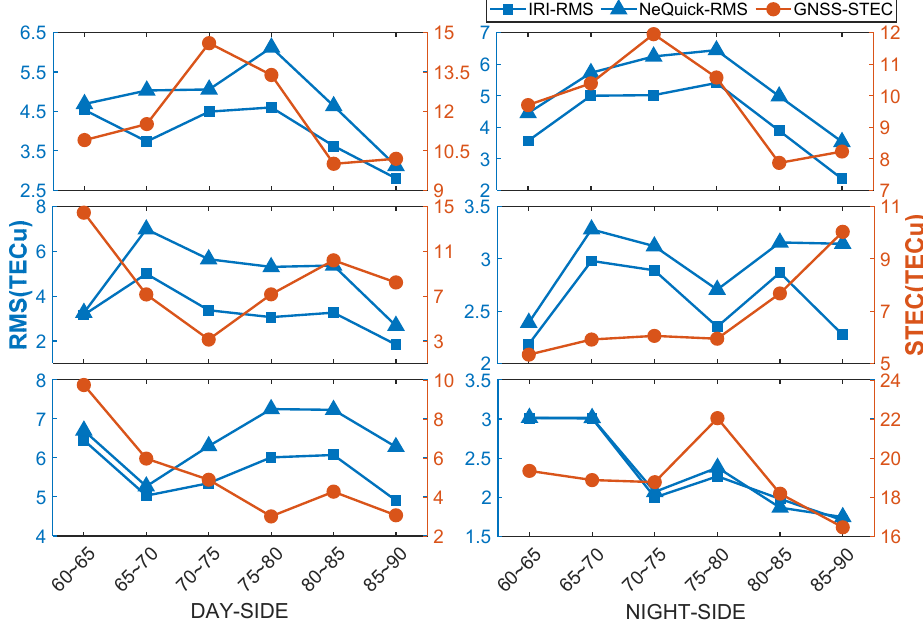
Figure 9. Variation in GNSS STEC and modeling Root Mean Square (RMS) values. Three rows are aligned vertically at both left- and right-hand sides, respectively. Left-hand side represents the statistics of the variation of GNSS STEC and RMS values of the two models with latitude in day side, while right-hand side represents in night side. The first row represents GNSS STEC and RMS variation of two models from 1:00 to 3:00 in March and September. The second row represents STEC and RMS variation of two models from 13:00 to 15:00 in March and September. The third row represents GNSS STEC and RMS variation of two models in June and December. Day side means polar day and night side means polar